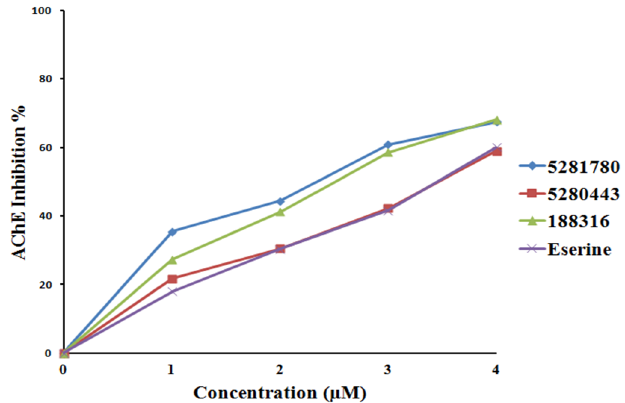
Figure 6. AChE inhibition percentage and inhibitor concentration plot.